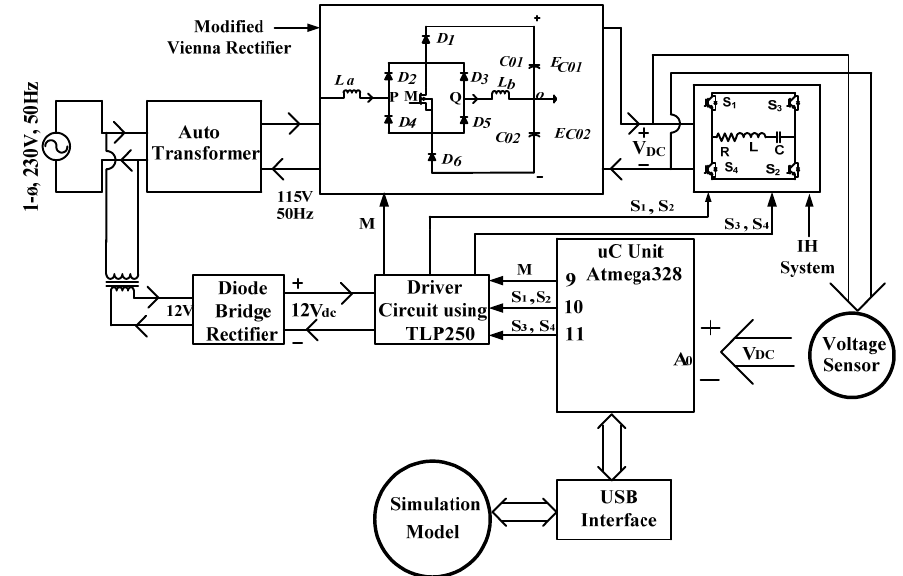
Figure 20. Basic structure of experimental setup.